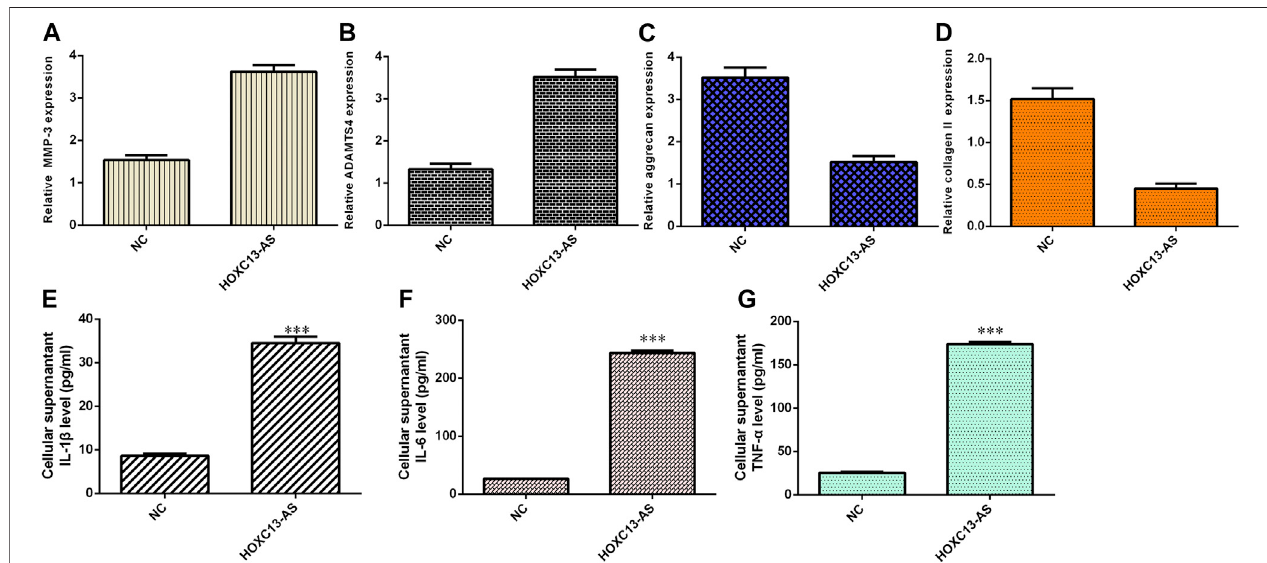
FIGURE 5 | HOXC13-AS induced in fl ammatory cytokine expression and ECM degeneration. (A) MMP-3 expression was measured by qRT-PCR. (B) Ectopic expression of HOXC13-AS promoted ADAMTS4 expression in NP cells. (C) Aggrecan expression was determined by qRT-PCR. (D) Collagen II expression was measuredbyqRT-PCR. (E) IL-1 β expressionwasdeterminedbyELISA. (F) IL-6expressionwasdetermined byELISA. (G) TNF- α expressionwasdetermined byELISA. *** p < 0.001.